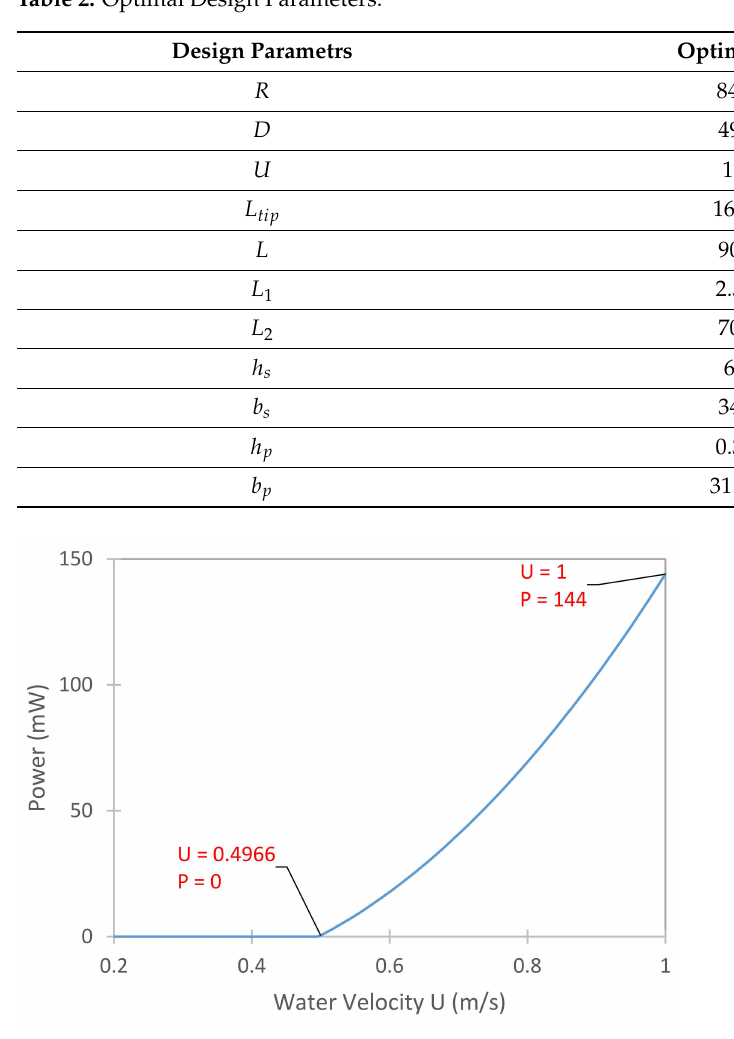
Figure 3. Graph Showing Variation of Power Output with Flow Velocity U .